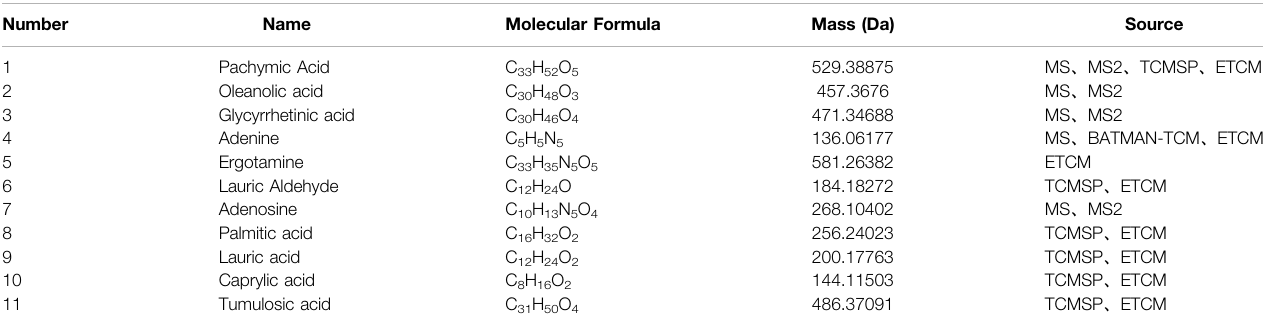
TABLE 1 | Chemical identi fi cation combining component characterization and database